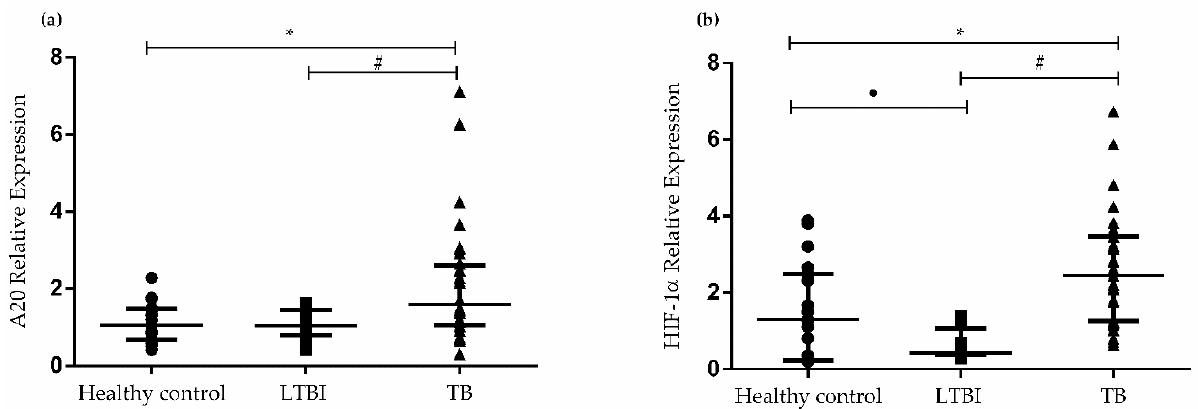
Figure 2. Gene expression of A20 and HIF1A in PBMCs of healthy controls, individuals with LTBI, and